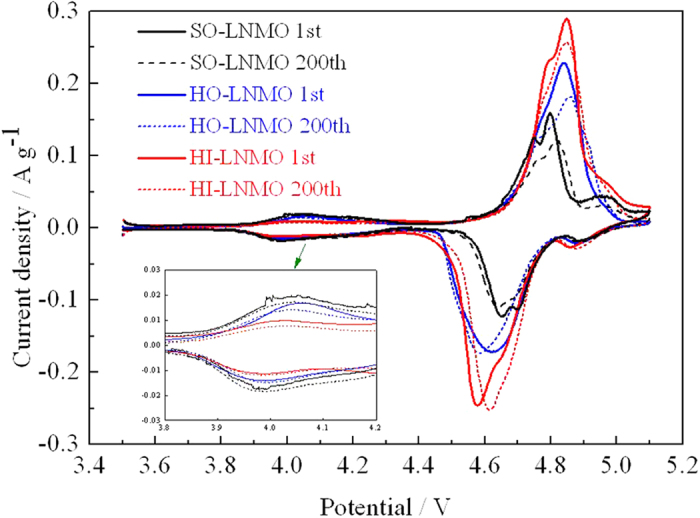
Cyclic voltammetry curves of LiNi0.5Mn1.5O4 with different microstructures before and after 200 cycles at a rate of 2 C.